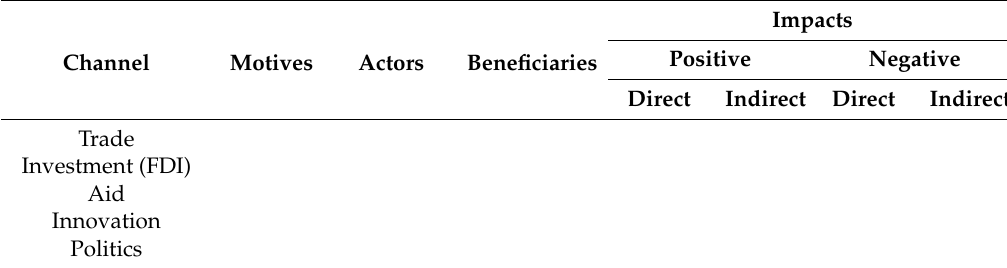
Table 2. The Asian Drivers framework applied to the study of large dams in